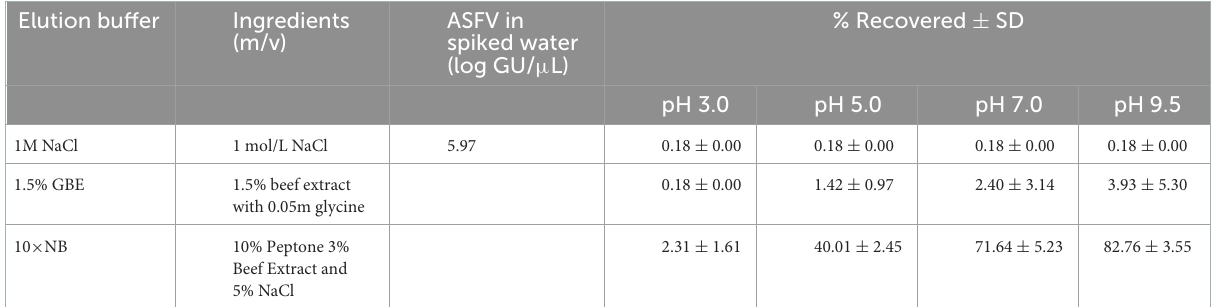
TABLE 1 Recovery efficiency of three elution buffers at different pH